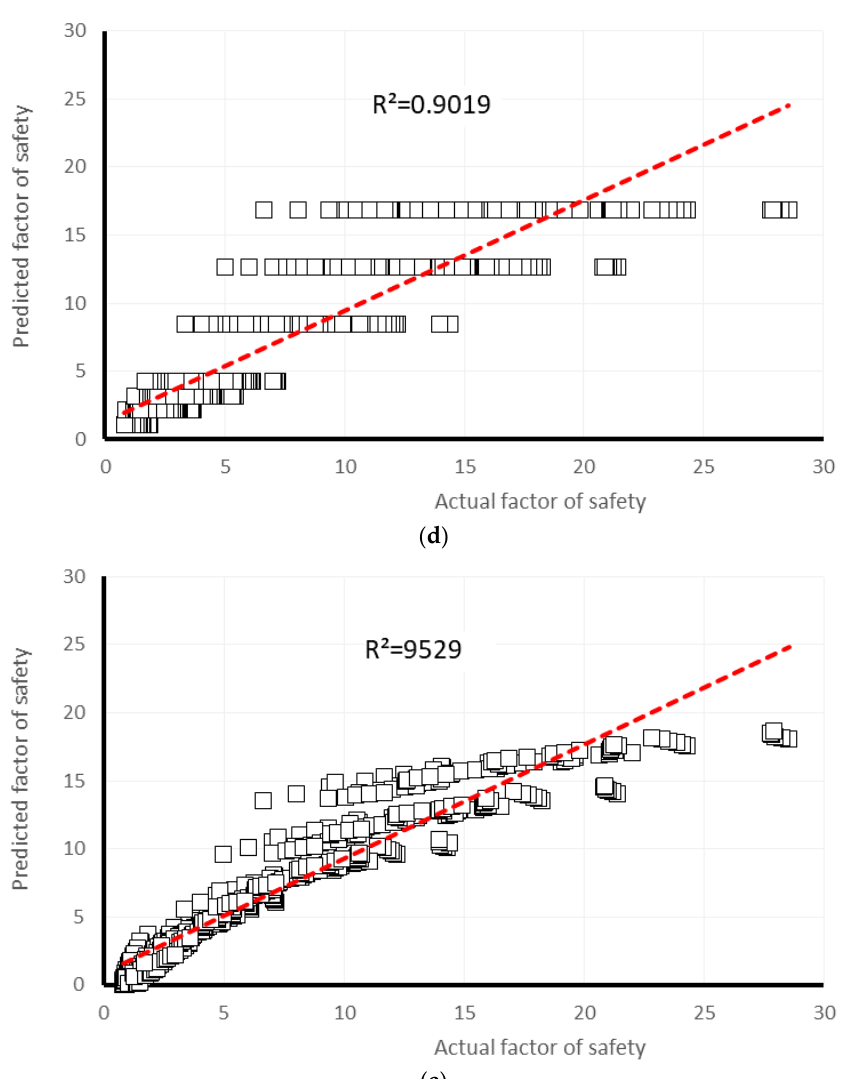
Figure 5. The results of correlation obtained for the training datasets after conducting various models in predicting safety factor ( a ) Gaussian processes regression, ( b ) multiple linear regression, ( c ) multi-layer perceptron, ( d ) simple linear regression, ( e ) support vector regression.